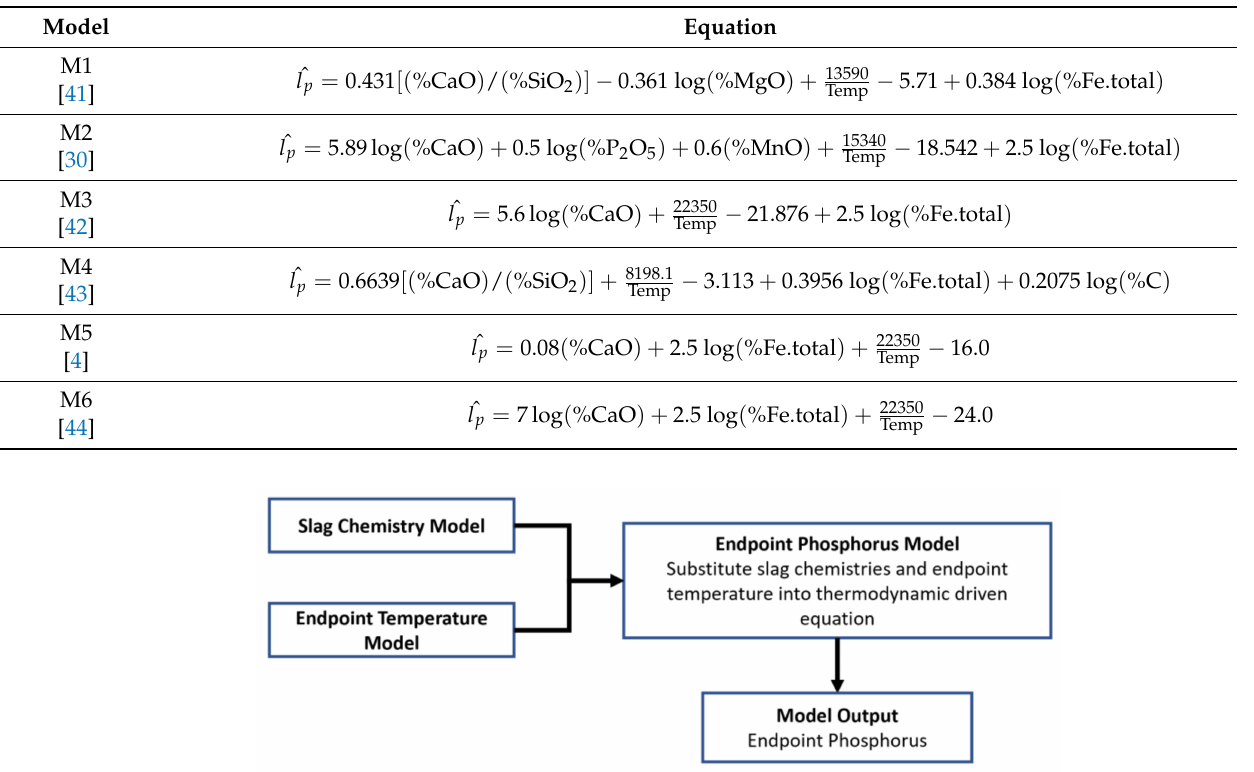
Table 3. Existing models to predict phosphorus partition ratio in steelmaking.